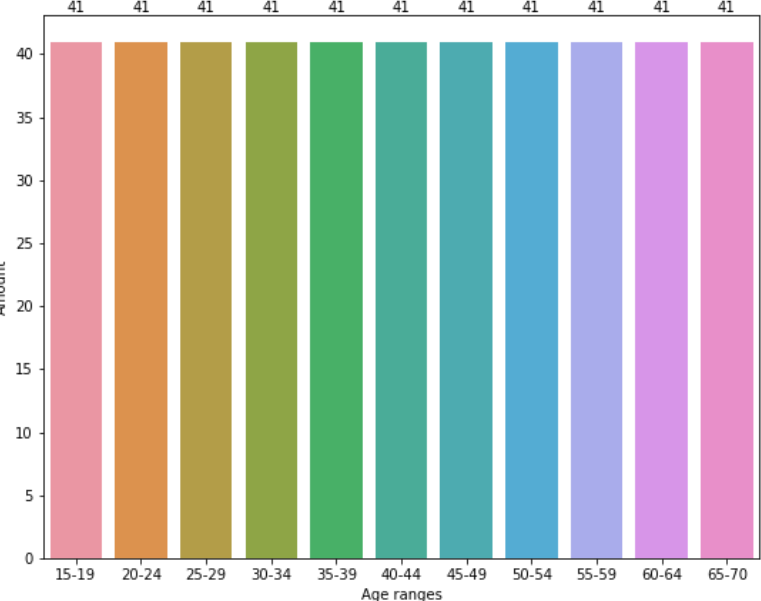
Figure 4. Original data corpus distribution among range-ages using